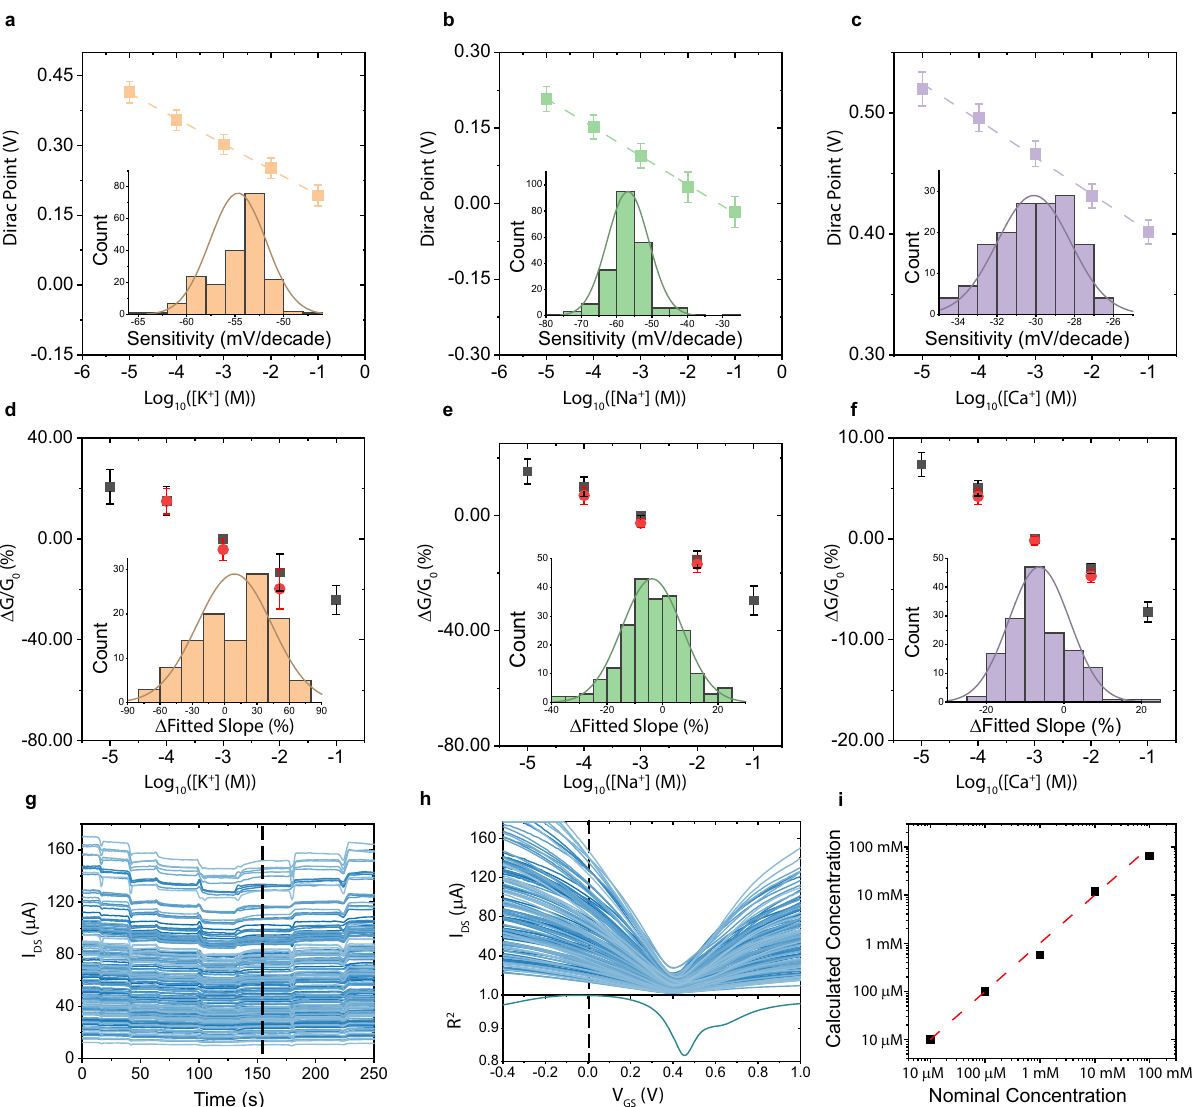
Fig. 2 | ISMs-functionalized graphene sensing chip and pro fi le matching cali- bration. The minimum conduction point as a function of ion concentration for a K + ISM, b Na + ISM, and c Ca 2+ ISM functionalized graphene sensor chips. Error bars indicate the standard deviation of the Dirac Points of all the working devices on the chip. Dashed lines are the linear fi ts of the Dirac Points and the slopes of the fi tted lines are the sensitivity. Insets depict the sensitivity dis- tributionofindividualdevicesoneachchip. d – f Theaveragechangeinchannel conductance for K + ISM, Na + ISM, and Ca 2+ ISM functionalized sensing chip showing excellent reversibility over several magnitude change in K + , Na + , and Ca 2+ concentration. Black dots are measurements going from low ion con- centration to high, while red dots are measurements going from high ion concentration to low. The percentage change in conductance is normalized